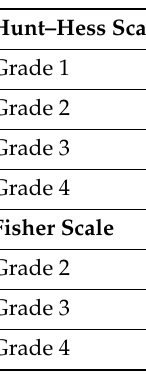
Table 2. Characteristics of patients with ruptured